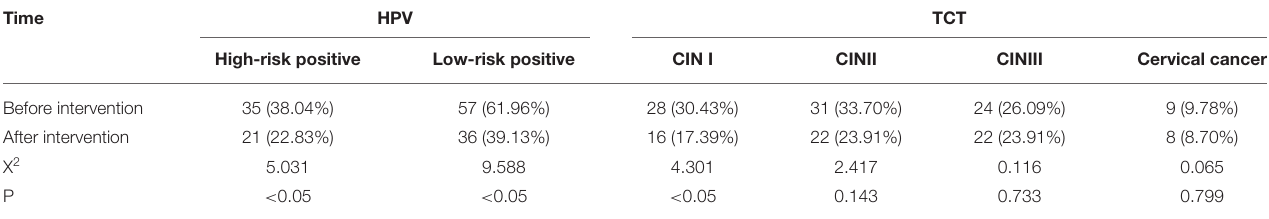
TABLE 4 | Control effect on high-risk population above the threshold [n(%)]. Time HPV TCT High-risk positive Low-risk positive CIN I CINII CINIII Cervical cancer Before intervention 35 (38.04%) After